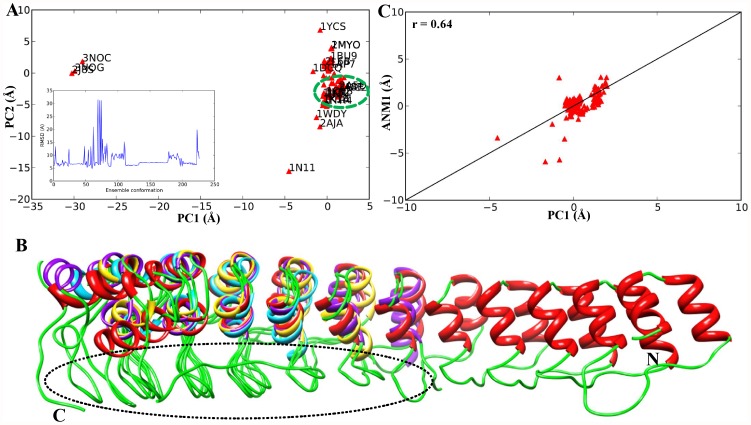
ARD structural analysis.(A) Projection of 227 ARD structures onto PC1 and PC2, represented as red triangles. The structures are separated into 4 distributions, and the NMR structures are labeled with their corresponding PDB IDs. The green dotted circle represents the cluster within which the IκBs are distributed. The inset shows the RMSD values of the 227 conformations, ranging from 4 to 30 Å. (B) Structural variations observed in the 4 distributions are illustrated using the selected structures (1N11, 1YCS, 1K1A, and 3NOG) labeled in (A). The 1N11, 1YCS, 1K1A, and 3NOG structures are in red, blue, purple and yellow, respectively. The finger loop regions are shown in green. (C) Projection of the 227 structures onto the PC1 and ANM1 directions.